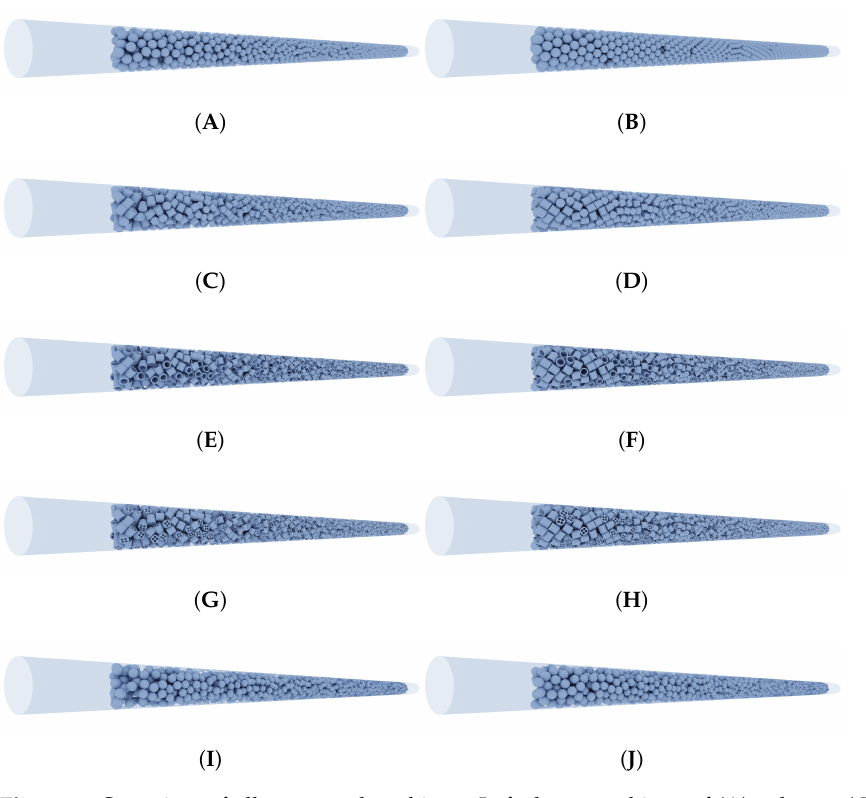
Figure 1. Overview of all generated packings. Left: loose packings of ( A ) spheres, ( C ) cylinders, ( E ) rings, ( G ) 4-hole cylinders, and ( I ) spheres with a macroscopic wall structure. Right: dense pack- ings of ( B ) spheres, ( D ) cylinders, ( F ) rings, ( H ) 4-hole cylinders, and ( J ) spheres with a macroscopic wall structure.